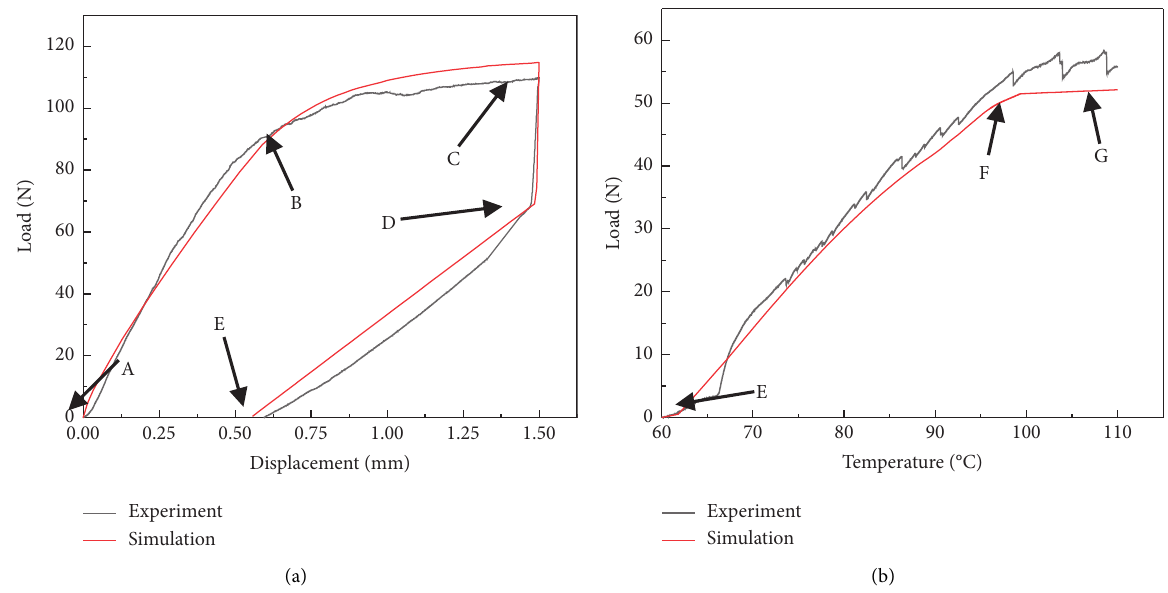
Figure 13: Experiment and simulation curves of large-pitch corrugated sample. (a) Compression-rebound curves of large-pitch corrugated sample. (b) Limited recovery load versus temperature curves for large-pitch corrugated specimen.